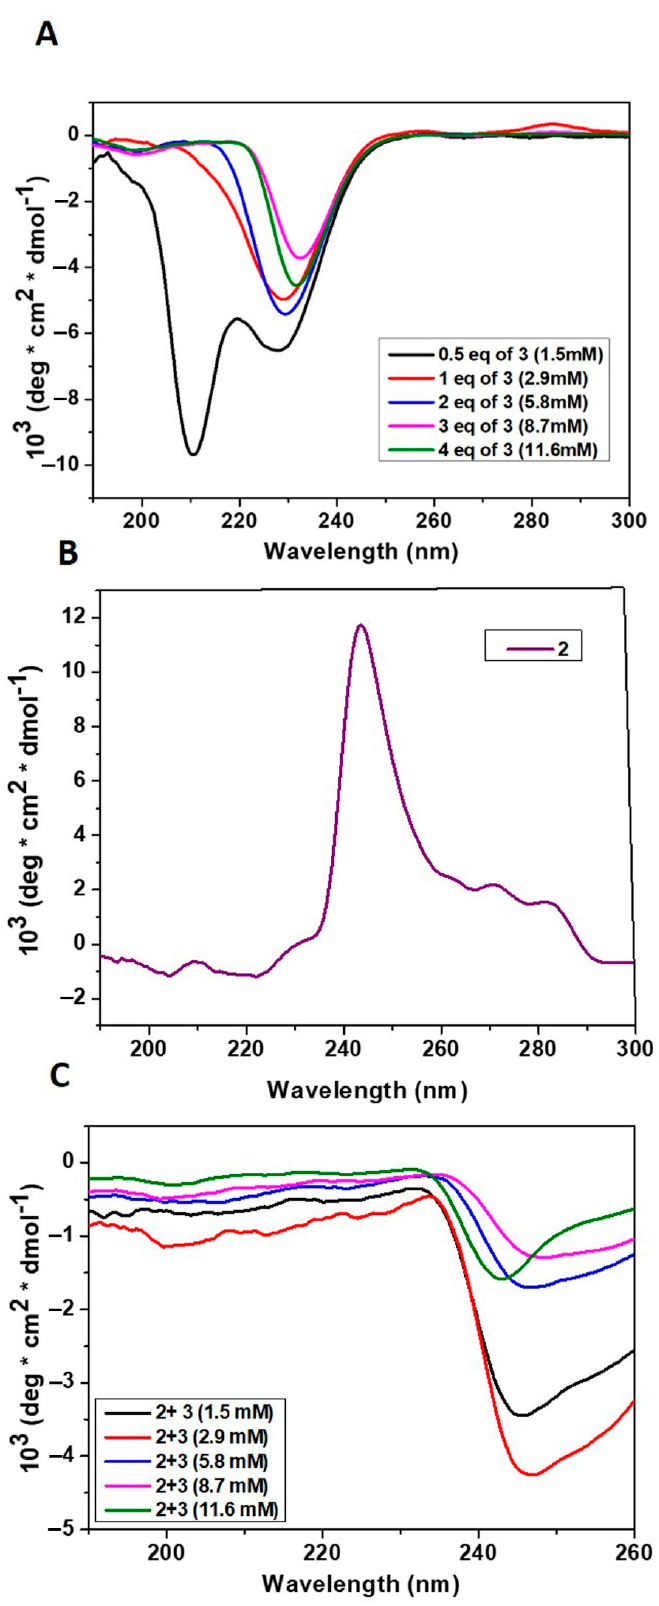
Figure 5. ( A ) CD spectrum of AcDALDLTD ( 3 ) at different concentrations (1.5, 2.9, 5.8, 8.7, 11.6 mM, which corresponds to 0.5, 1, 2, 3, and 4 equiv. (molar ratio) of 2 (at 0.4 wt%)). ( B ) CD spectrum of 0.4 wt% NapFFKKFKLKL ( 2 ) alone. ( C ) 2 with the addition of 0.5, 1, 2, 3, and 4 equiv. (molar ratio) of AcDALDLTD. ( 3